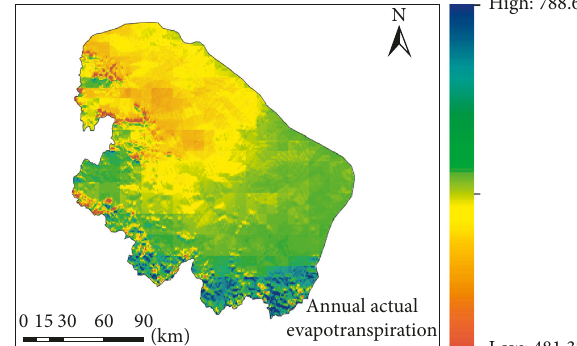
Figure 4: Spatial distribution of annual actual evapotranspiration in the upper reach of the Huaihe River Basin for the period 1961–2000.